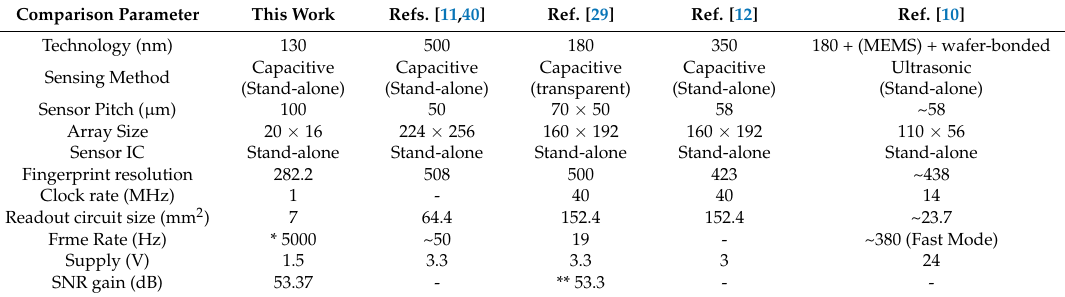
Table 5. Performance summary and comparison with recent